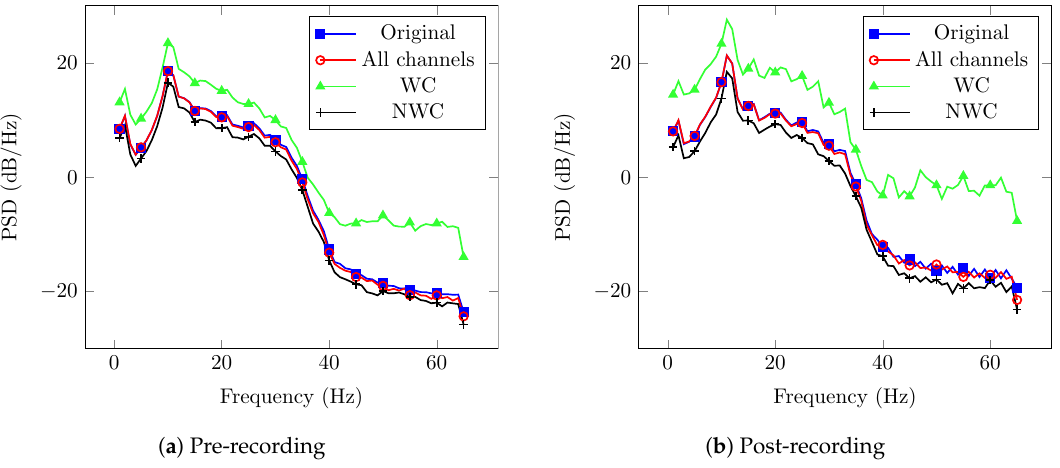
Figure 3. PSD results from EnKF outputs of User